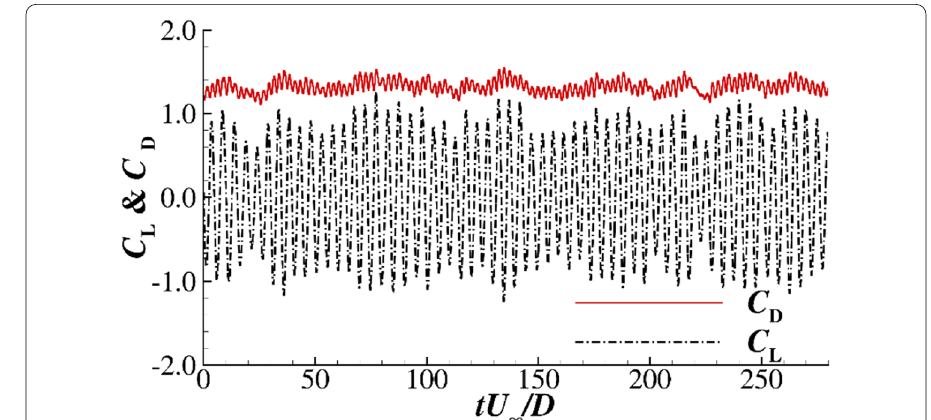
Fig. 4 Histories of the lift and drag coefficients